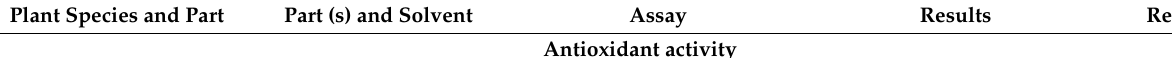
Table 6. Pharmacological studies on some of the plant species of Bombacoideae